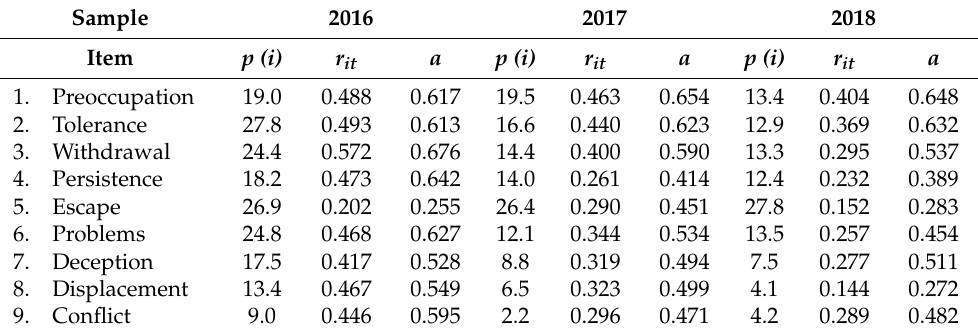
Table 4. Item analyses of the Internet Gaming Disorder Scale IGDS in three different samples.